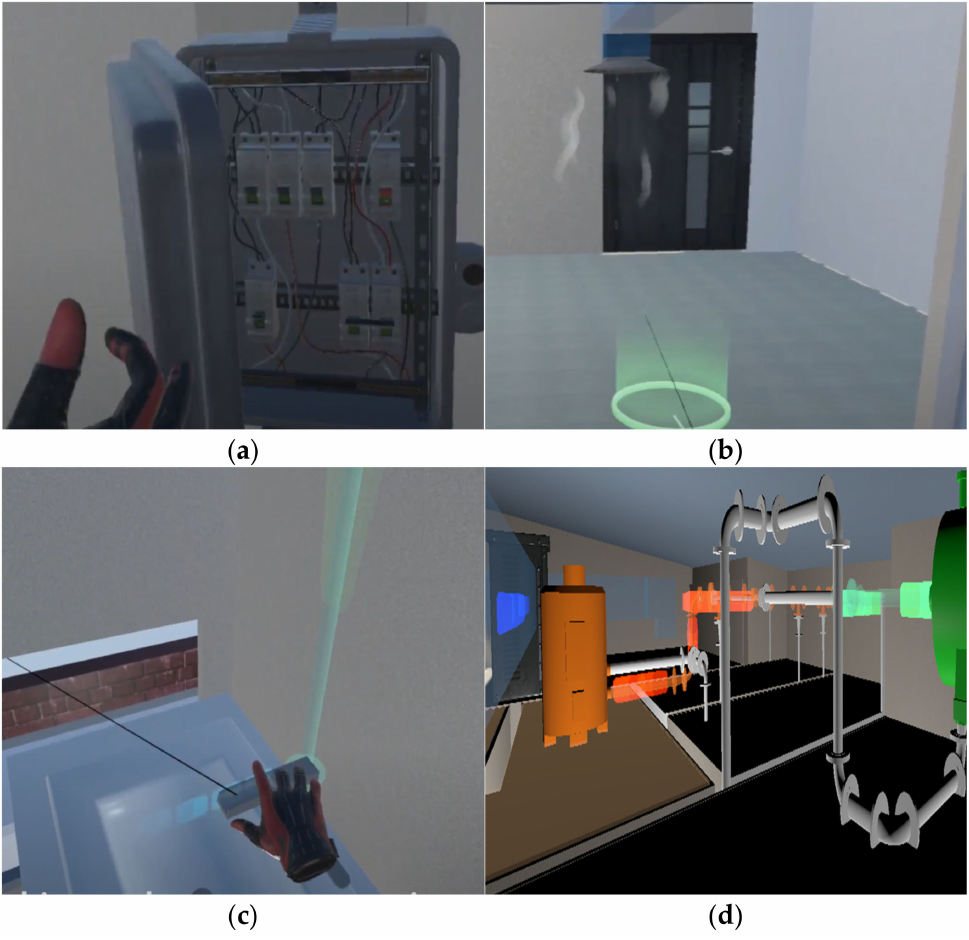
Figure 4. Interactive-based training scenario. ( a ) User interacting with the electrical system; ( b ) Visualization of the air ventilation in the building; ( c ) User interacting with the main water supply system; ( d ) Fully animated HVAC and piping systems showing air and water flow